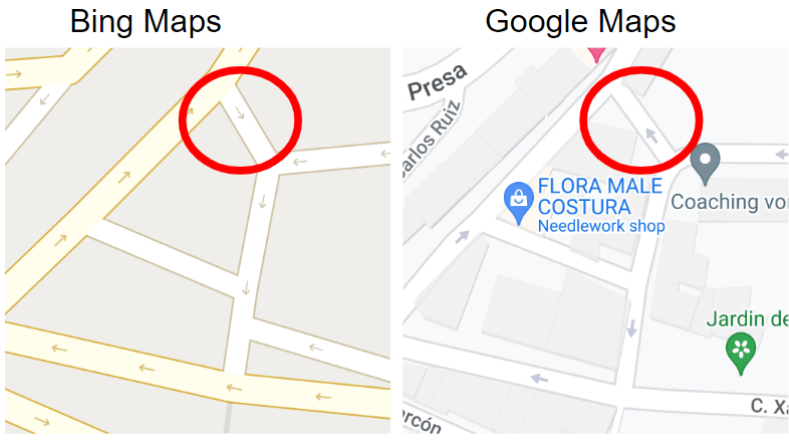
Figure 20. Type 2 (strong discrepancy) example #2-Spain. Similarly, our system detects strong discrepancies of 0.45% in Italy and 0.19% in Mexico for the Google Maps vs. Bing Maps comparison. Figures 21–23 show some